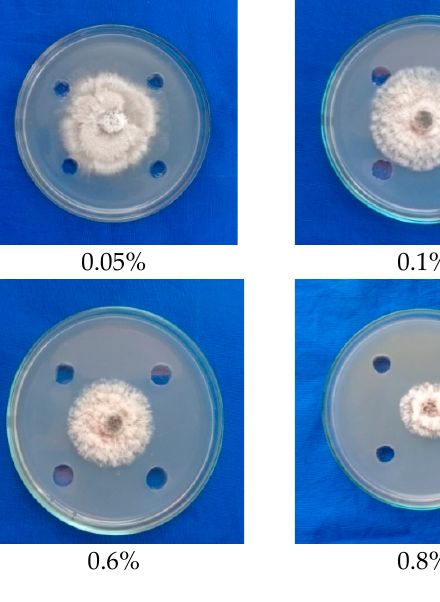
Figure 2. Testing the ethyl acetate-extracted antimicrobial compounds from fruiting body (cap) of G. lucidum against mycelial growth of C. gloeosporioides.